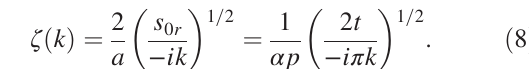
FIG. 2. The function e x erfc ð ffiffi p x mation e − , which differs by less than 1.2% over the range plotted (orange